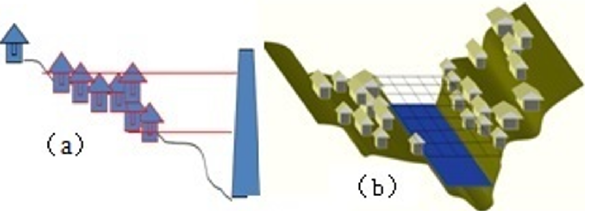
Figure 1. Comparison of effects of static and non-static water